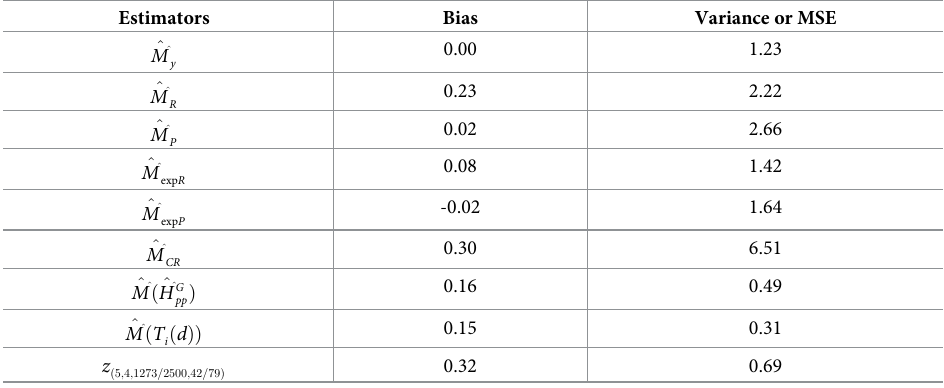
Table 5. Bias and MSE values of members of the proposed class of estimators for population